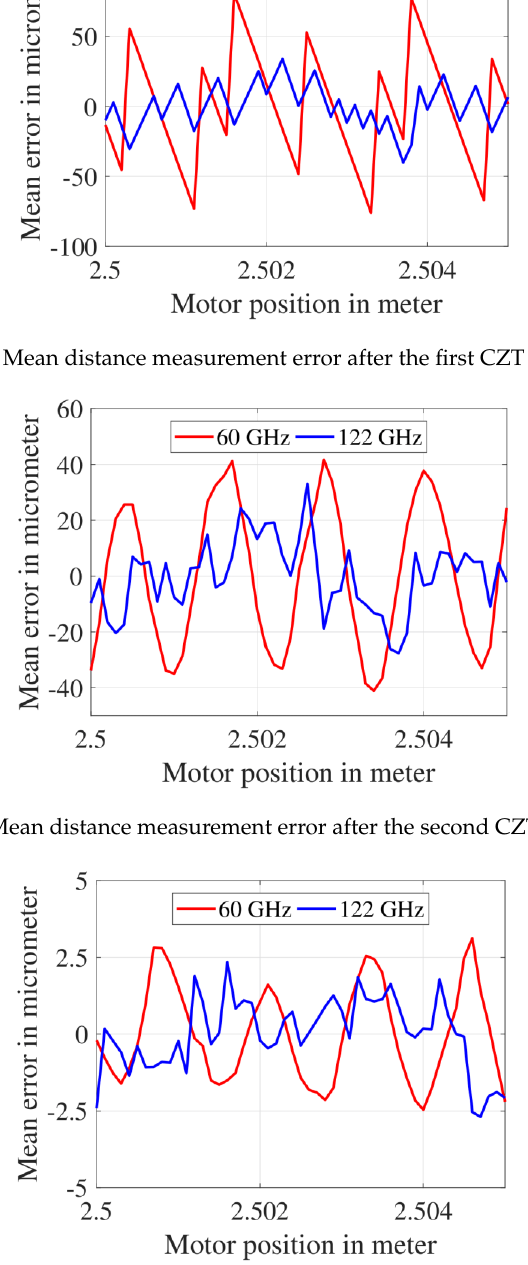
Figure 10. Mean distance measurement error after the combined frequency- and phase-estimation.